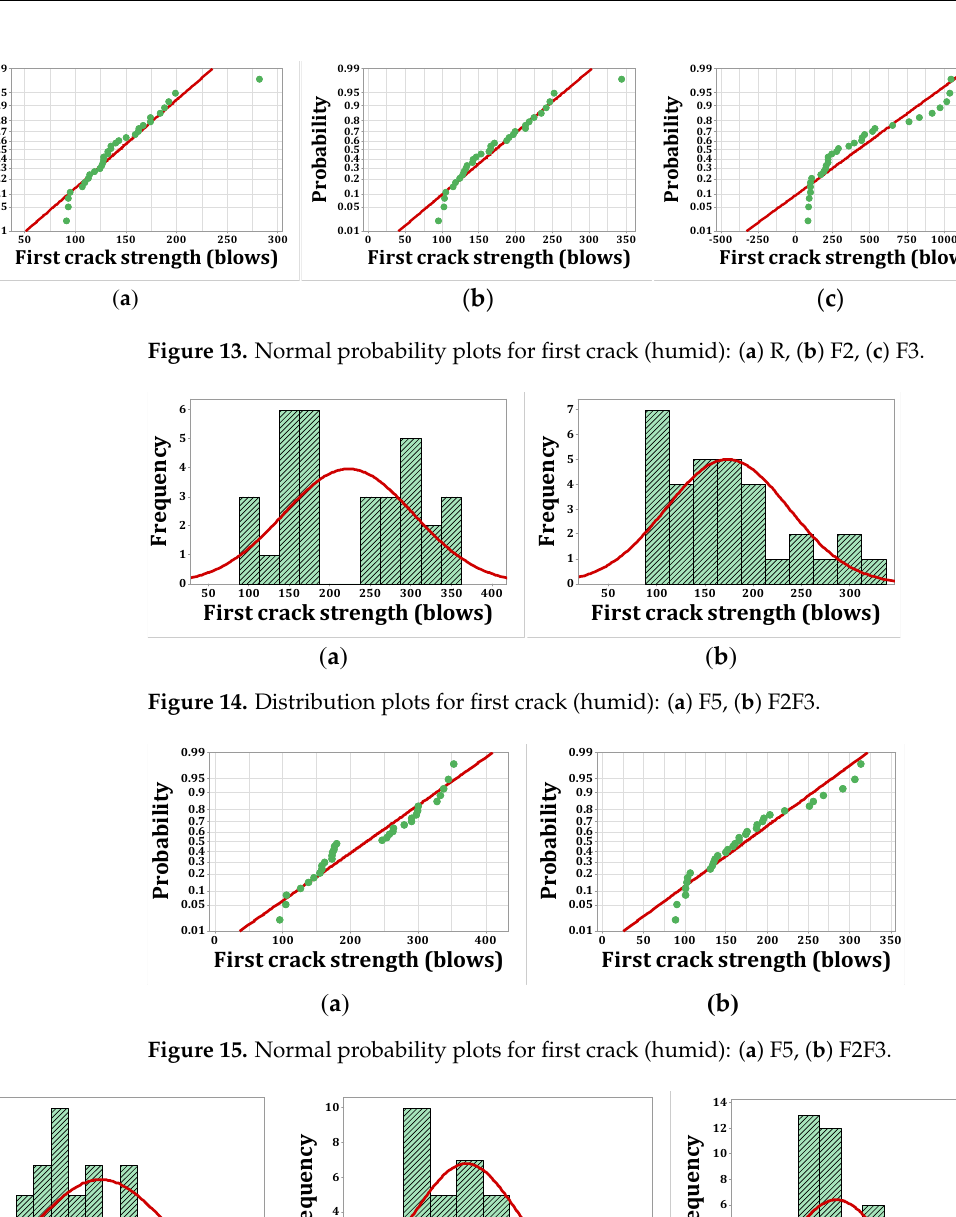
Figure 12. Distribution plots for first crack (humid): ( a ) R, ( b ) F2, ( c ) F3.